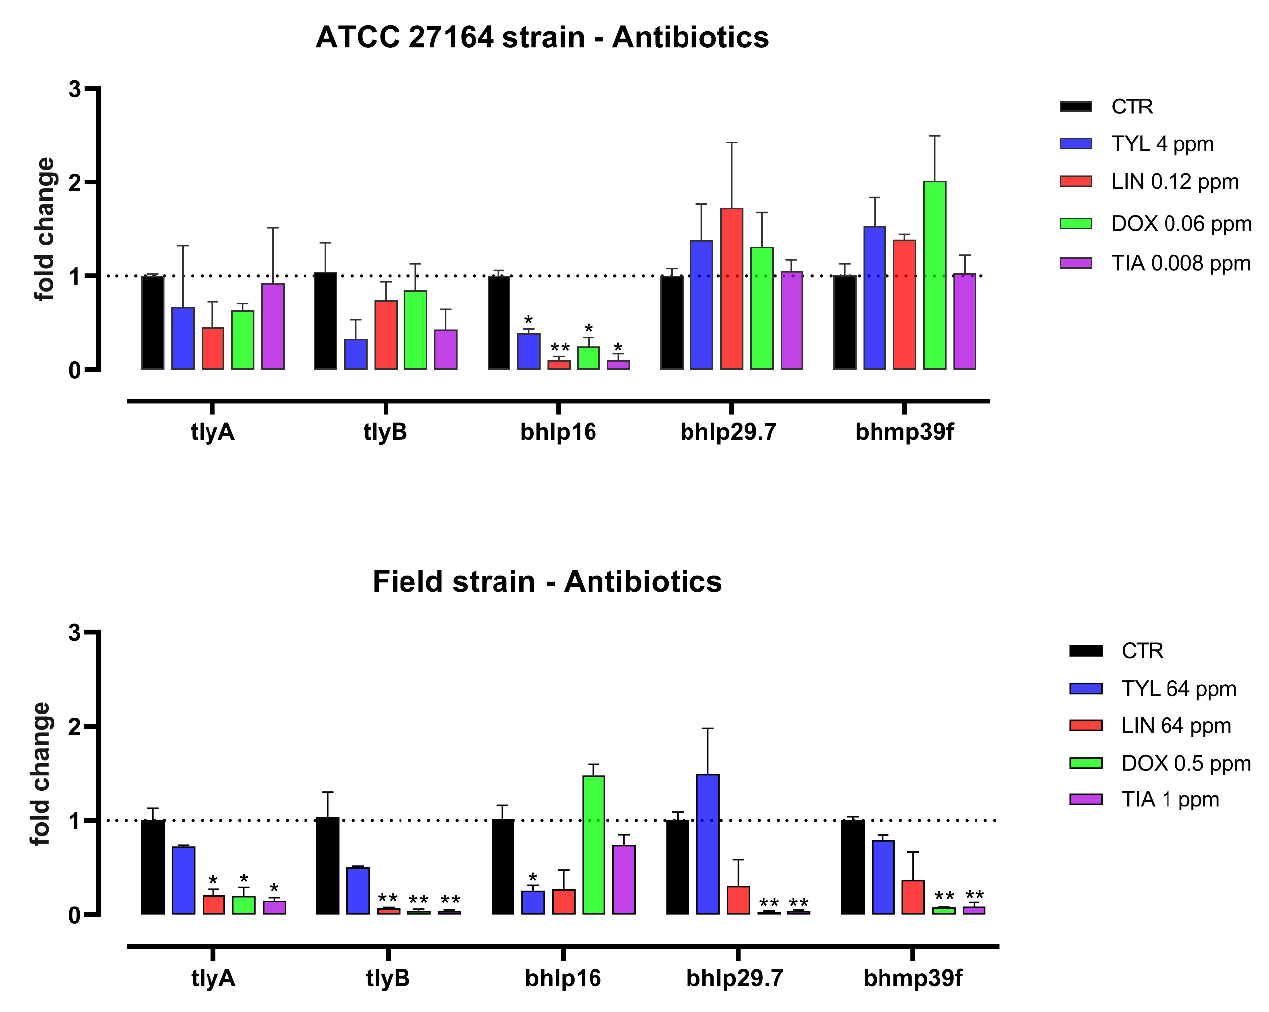
Figure 1. mRNA expression of tlyA , tlyB , bhlp16 , bhlp29.7 , and bhmp39f for B. hyodysenteriae ATCC 27164 and the field strain cultured alone (CTR), or with sub-inhibitory doses of antibiotics. Data are presented as mean (n = 3) ± SEM. For each gene, significant differences between each substance and its control are marked by asterisks (* for p < 0.05 and ** for p < 0.01). TYL = tylosin, LIN = lincomycin, DOX = doxycycline, TIA = tiamulin.